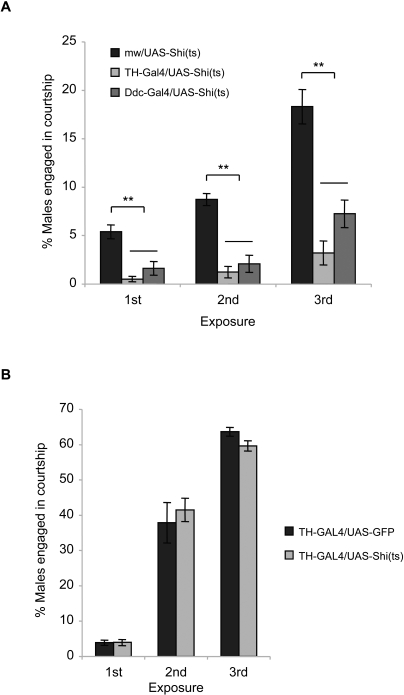
Effects of inhibited dopamine neuronal activities on the ethanol-induced courtship.(A) TH-GAL4/UAS-Shits and DDC-GAL4/UAS-Shits males, when subjected to daily ethanol exposure at 32°C to block synaptic output of dopamine neurons, displayed drastically reduced intermale courtship compared to the control mw+/UAS-Shits males on all exposures (1st exposure, F2,21 = 18.24, p<0.0001; 2nd, F2,21 = 35.26, p<0.0001; 3rd, F2,21 = 27.02, p<0.0001; n = 7–8). Double asterisks, significant difference by Tukey-Kramer tests. (B) TH-GAL4/UAS-Shits males, when subjected to daily ethanol exposure at room temperature, showed intermale courtship activities comparable to those of the control TH-GAL4/UAS-GFP males, indicating that Shits expressed in dopamine neurons without the dominant negative activity has no effect on the ethanol-induced intermale courtship (Student t-test on all exposures, p>0.5, n = 7).